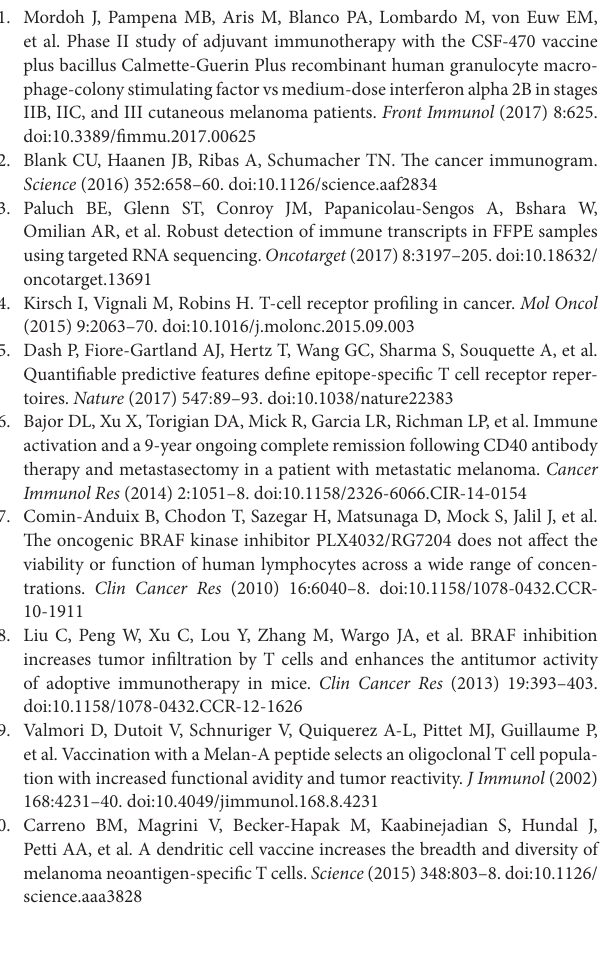
taBLe s2 | Peripheral blood mononuclear cells-PRE productive rearrangements. taBLe s3 | Peripheral blood mononuclear cells-POST-1 productive rearrangements. taBLe s4 | Peripheral blood mononuclear cells-POST-3 productive rearrangements. taBLe s5 | Peripheral blood mononuclear cells-POST-4 productive rearrangements. taBLe s6 | Tumor-infiltrating lymphocytes productive